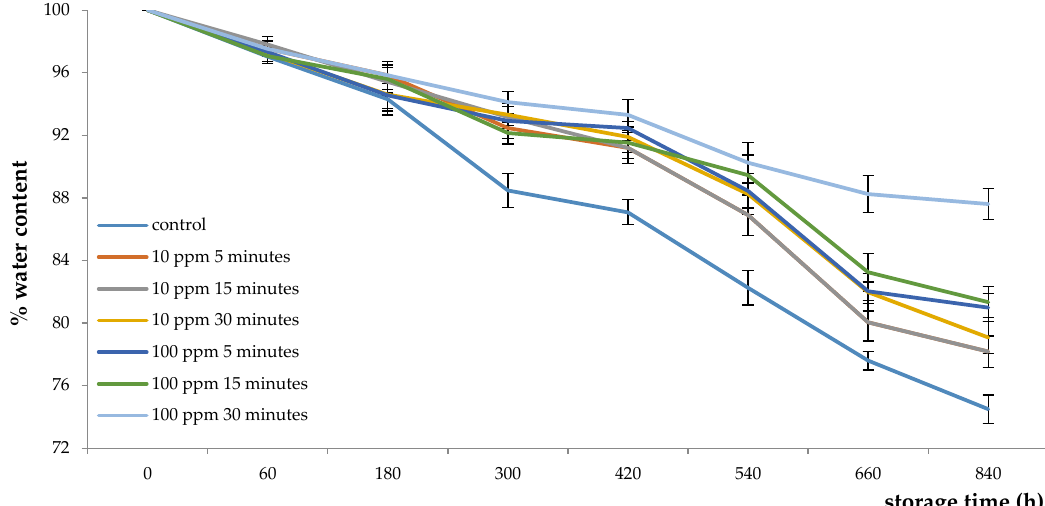
Figure 1. Water content in the samples subjected to ozone treatment and in the control sample on the consecutive dates related to storage of rhubarb petioles.